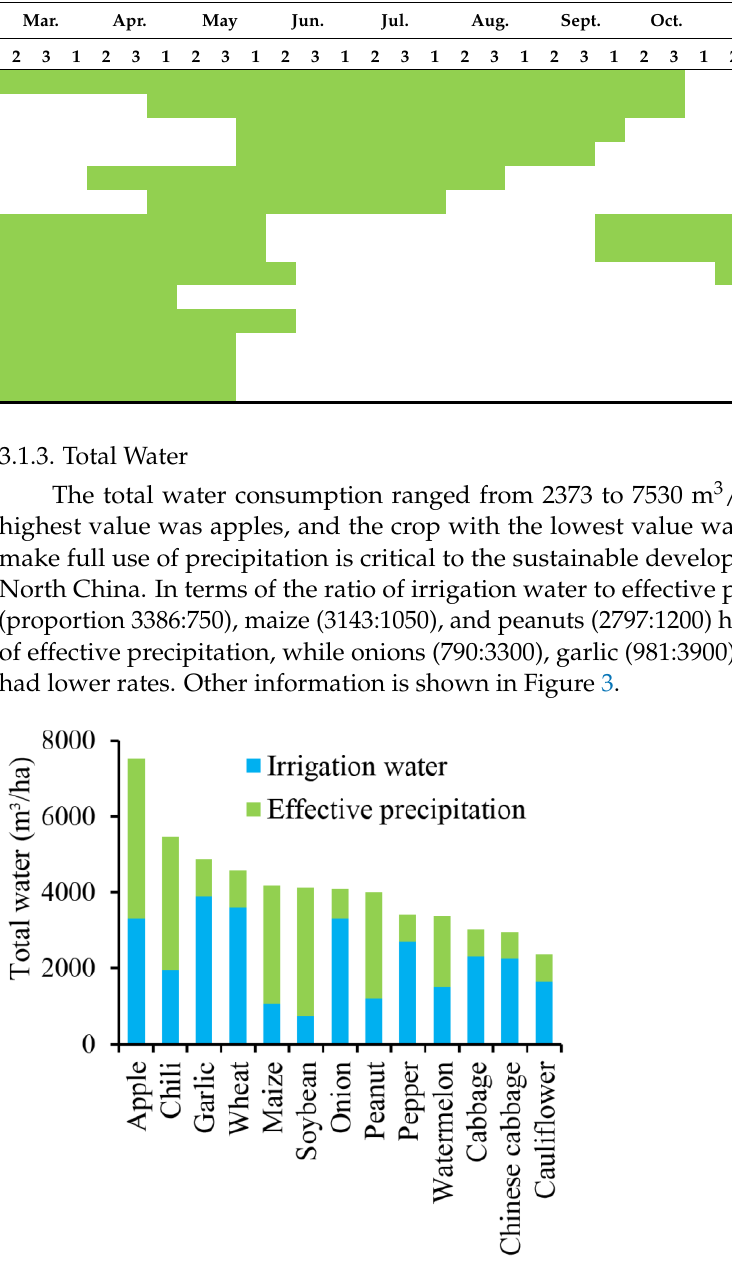
Figure 3. Irrigation water and effective precipitation of the studied crops.